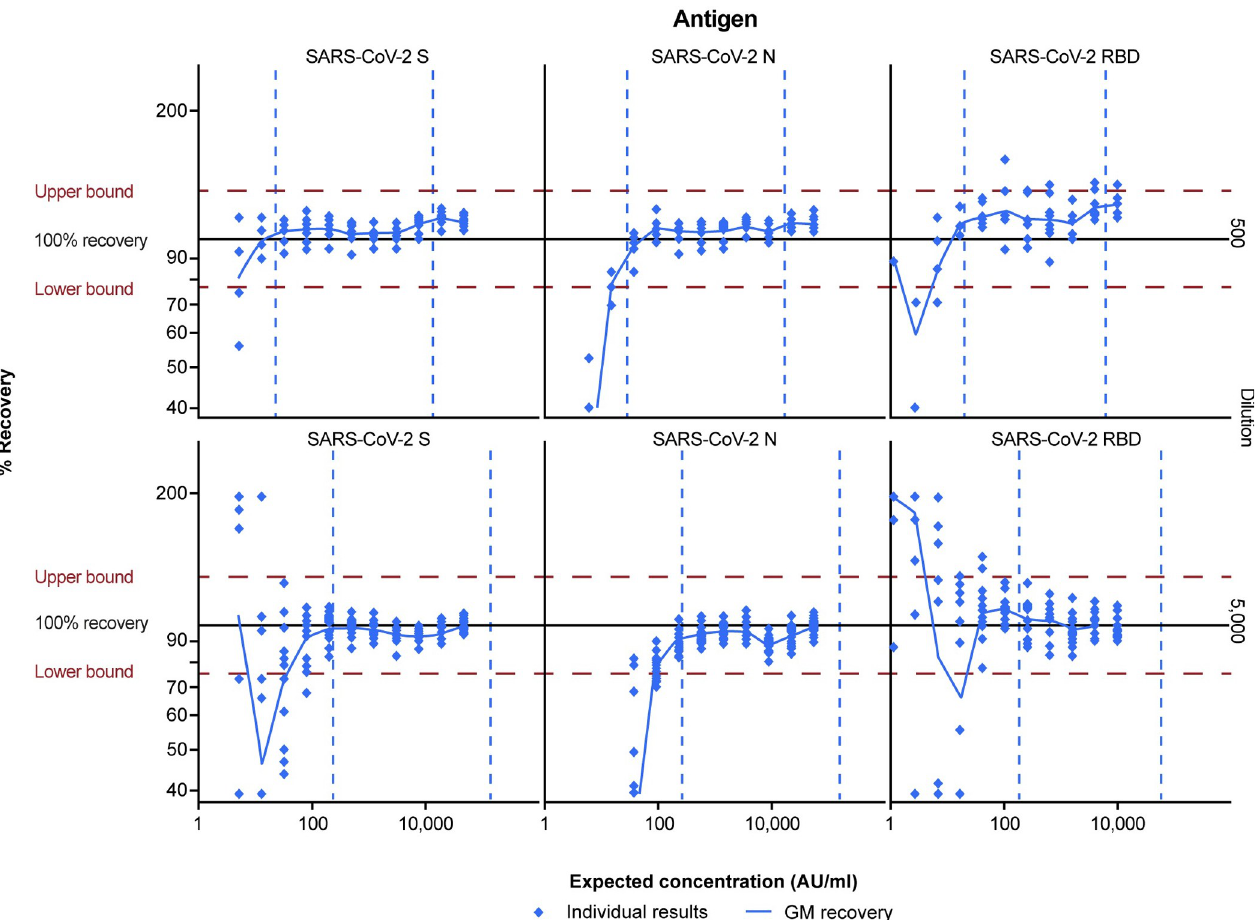
Fig 4. Anti-SARS-CoV-2 antibody MSD ECL assay relative accuracy. Overall and individual percentage recovery estimates (across 15 runs) are shown for each of the three antigens in the assay, SARS-CoV-2 spike (SARS-CoV-2 S), nucleocapsid (SARS-CoV-2 N), and receptor-binding domain (SARS-CoV-2 RBD), in a two-fold dilution series with expected concentrations from 51,171 to 5.4 AU/ml, 54,748 to 5.7 AU/ml, and 10,802 to 1.1 AU/ml, for SARS-CoV-2 S, SARS-CoV-2 N, and SARS-CoV-2 RBD, respectively. The horizontal red dashed lines represent the pre-defined criteria for assay accuracy of 77% to 130%. Vertical dashed lines represent the LLOQ and ULOQ. AU = arbitrary units; GM = geometric mean; LLOQ = lower limit of quantitation; SARS-CoV-2 = severe acute respiratory syndrome coronavirus 2; ULOQ = upper limit of quantitation.